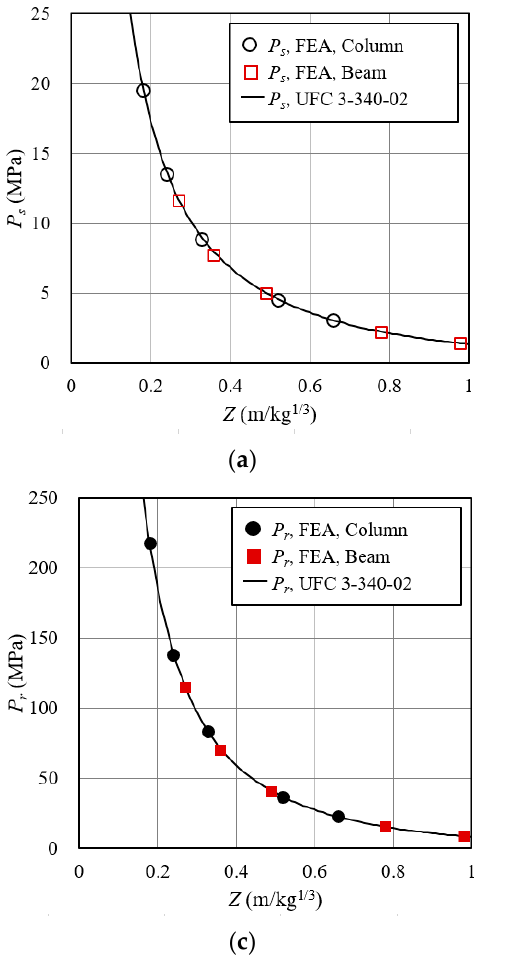
Figure 6. Verification of blast loadings based on UFC 3-340-02. ( a ) P s ; ( b ) I s ; ( c ) P r ; ( d ) I r .